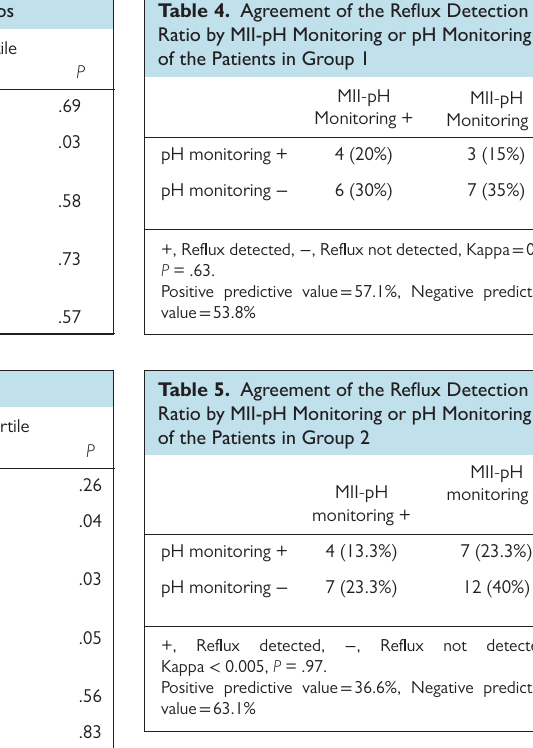
Table 4. Agreement of the Reflux Detection Ratio by MII-pH Monitoring or pH Monitoring of the Patients in Group 1